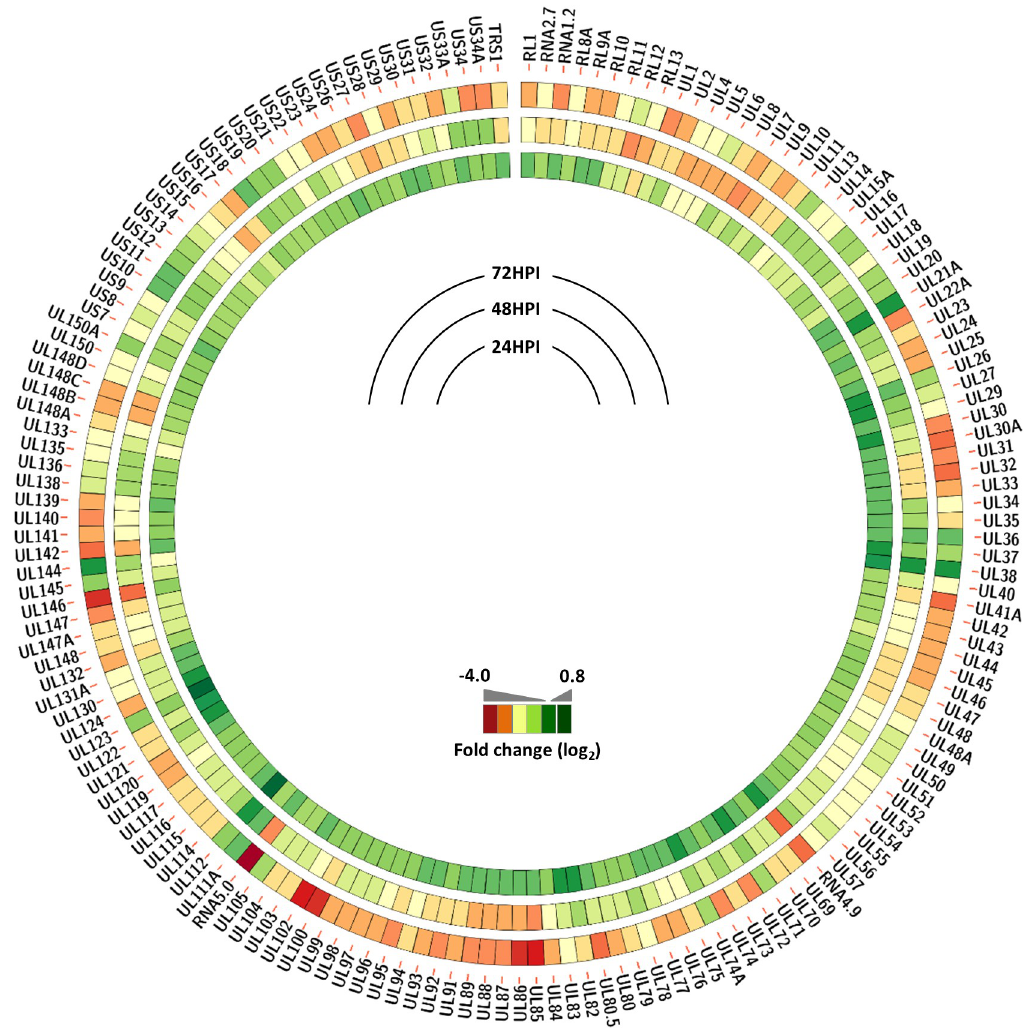
Fig 7. Expression of a subset of viral genes remains high following VCP knockdown, despite loss of IE2 expression. Read counts were alignedto the TB40E genomesequenceand normalised for total reads and CDS length. Differencein transcription at each time point was determined by calculatingthe Log 2 ratio in normalised read counts betweencontrol infected cells and VCP knockdown infected